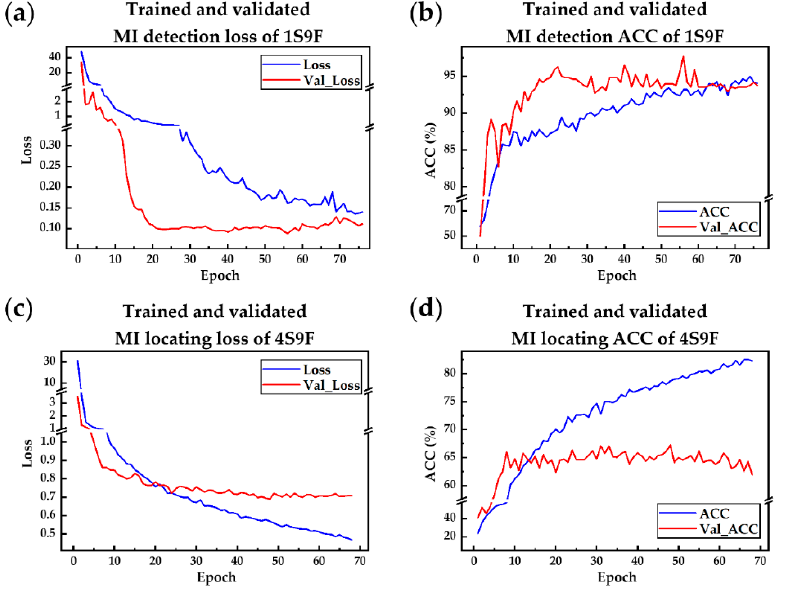
Figure 10. The performances of the proposed networks were recorded during each epoch where 1S indicates networks using single-scale features, 9F indicates networks using nine filters, and so on. ( a ) Trained and validated loss of MI detec- tion model during each epoch; ( b ) Trained and validated the accuracy of MI detection model during each epoch; ( c ) Trained and validated loss of MI locating model during each epoch; ( d ) Trained and validated the accuracy of MI locating model during each